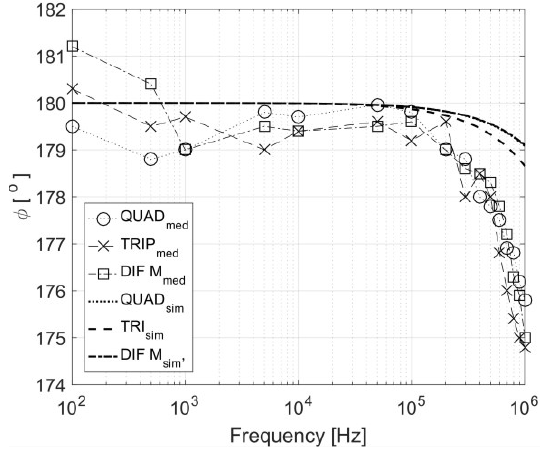
Fig.24: Measured and simulated output current phase for a 1 kΩ load. a) QUAD b) DIF_C c) DIF_M.